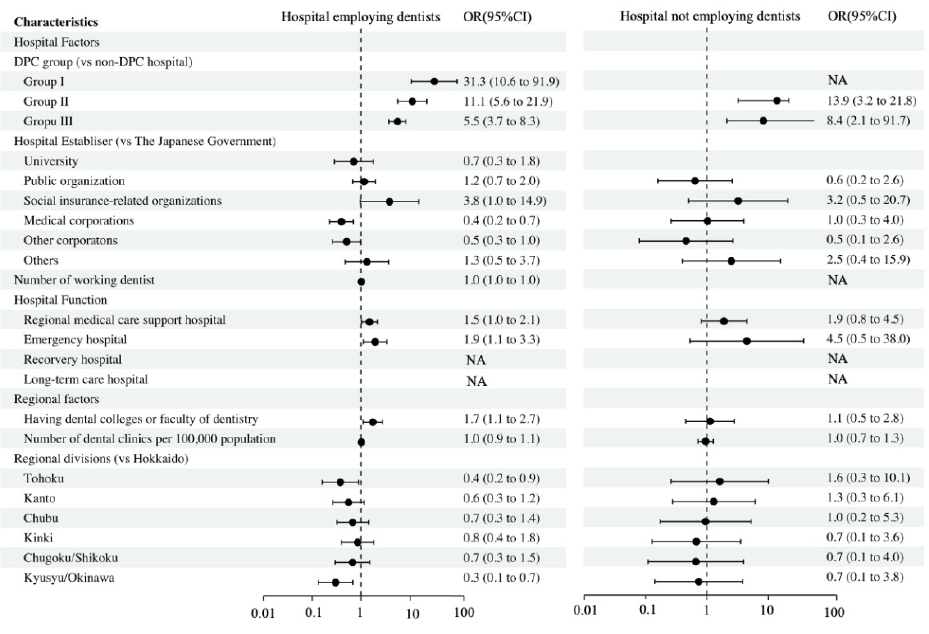
Figure 4. Factors associated with hospitals providing perioperative oral care based on dentist em- ployment status. Abbreviations: OR, odds ratio; 95% CI, 95% confidence interval. employment status. Abbreviations: OR, odds ratio; 95% CI, 95% confidence